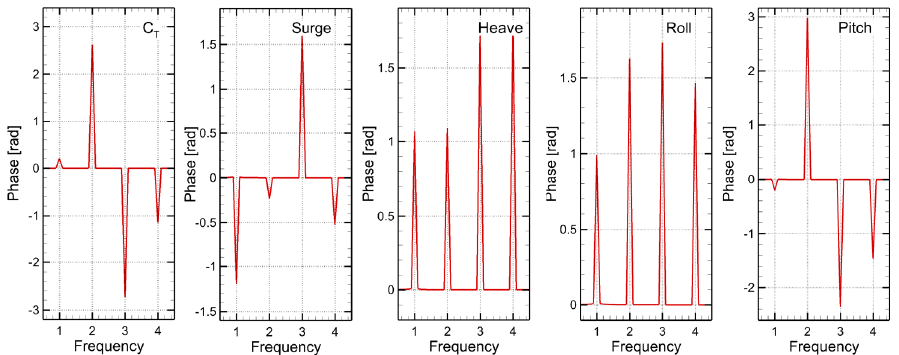
Figure 21. Harmonic phases of the total resistance coefficient ( C T ) , surge ( x ) , heave ( z ) , roll ( ϕ ) , and pitch ( θ ) for the beam waves FRxz ϕθ scenario.